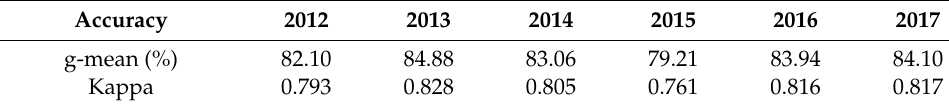
Table 2. Mean accuracy of urban area extraction in the